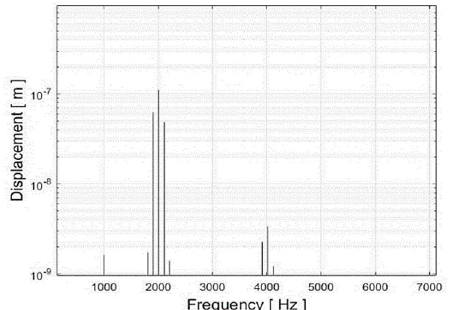
Figure 6. Frequency spectrum of the radial displacement of a point on the stator outer boundary .